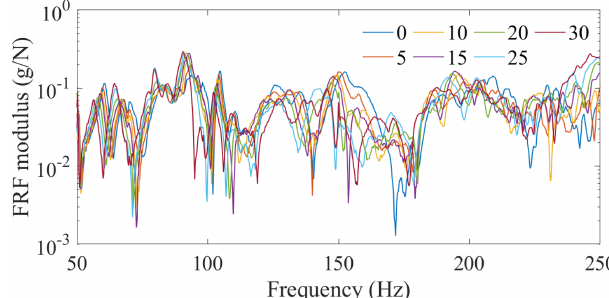
Figure 4. An example of temperature effect on frequency response: normal condition FRFs collected at seven different temperatures from sensor